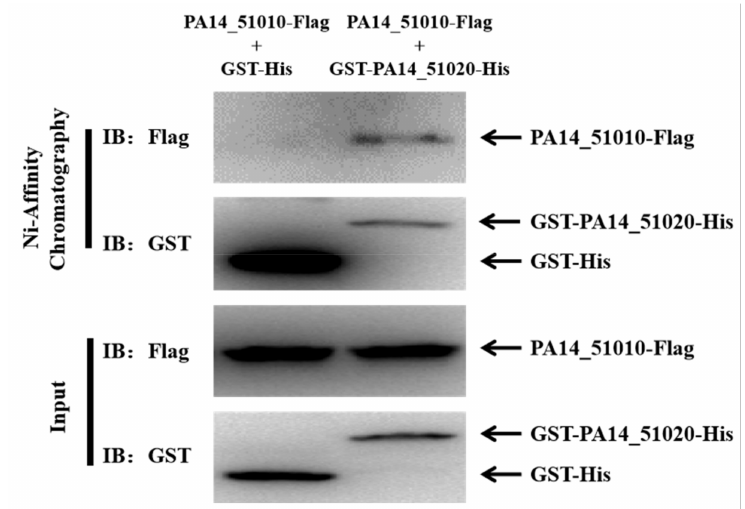
Figure 3. Interaction between PA14_51020 and PA14_51010. DH5 α cells carrying pMMB67EH-GST- His or pMMB67EH-GST- PA14_51020 -His were grown to an OD 600 of 0.6 and then grown in the presence of 1 mM isopropyl- β -d-thiogalactoside (IPTG) for 4h. The bacteria were lysed and subjected to chromatography with Ni-NTA beads. The bound protein was eluted by the elution buffer. The lysate of DH5 α cells expressing the pMMB67EH- PA14_51010 -Flag was mixed with same amount of the purified GST-His or GST-PA14_51020-His. Then, the mixtures were subjected to chromatography with Ni-NTA beads. The Flag-tagged PA14_51010, GST-tagged PA14_51020 and GST were detected by Western